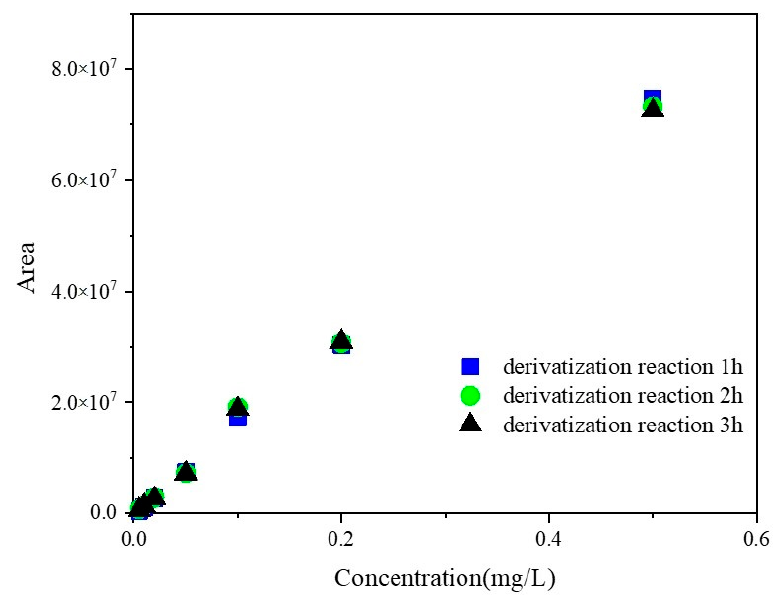
Figure 2. Peak areas of derivatives from 0.005 and 0.5 mg/L GLUF-P at 1 h, 2 h, and 3 h.